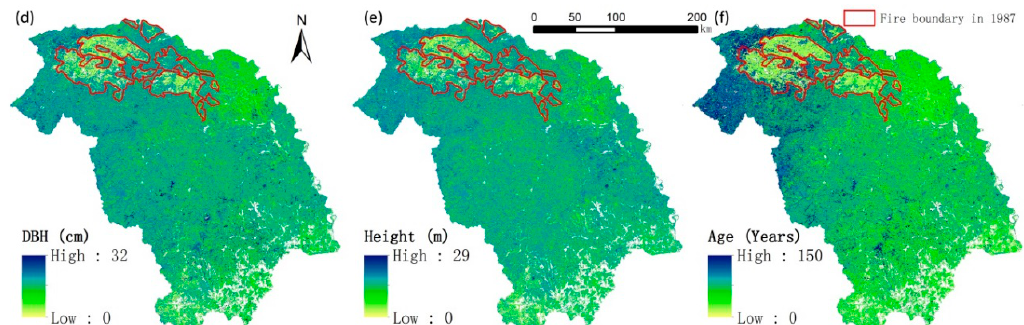
Figure 3. Goodness-of-fittings (density scatterplots) of the random forest (RF)-based kNN models of stand DBH, height, and age ( a – c ) and maps of estimated diameter, height, and age ( d – f ). The points superimposed on the density image are the points from those areas of lowest regional densities, which are the identification of outliers. The dotted line is the 1:1 line and the dashed line is the geometric mean functional regression line.